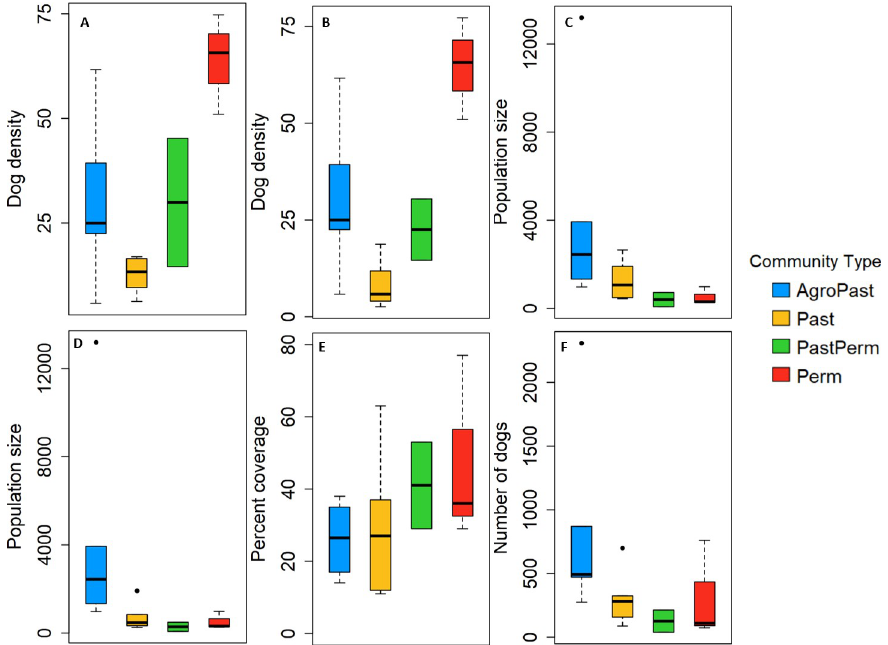
Fig 3. Domestic dog demographics and percent coverage estimates by community type. Box plots depicting domestic dog density based on (A) household surveys and (B) combination of mark-resight and household surveys, domestic dog population size using (C) household surveys only and (D) combined household and mark-resight estimates. (E) Percent coverage based on average number of dogs per household estimates and (F) number of dogs vaccinated during